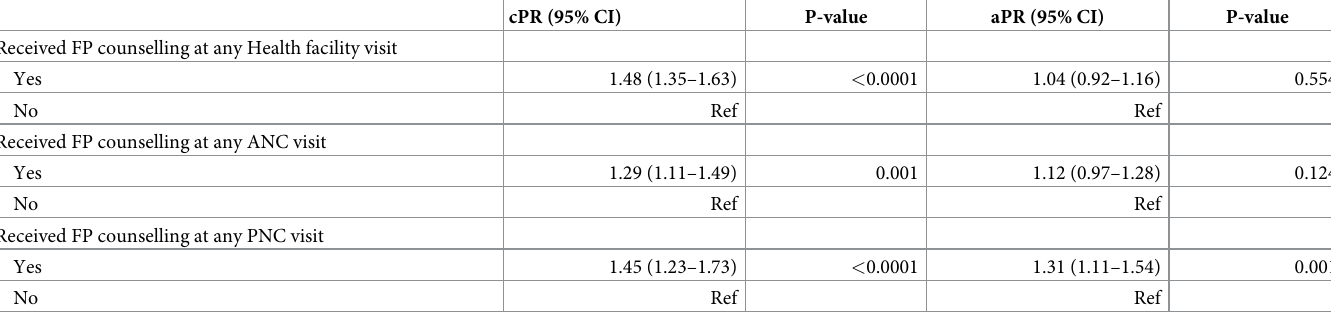
Table 3. Receipt of FP counselling associated with current use of modern contraception (n =